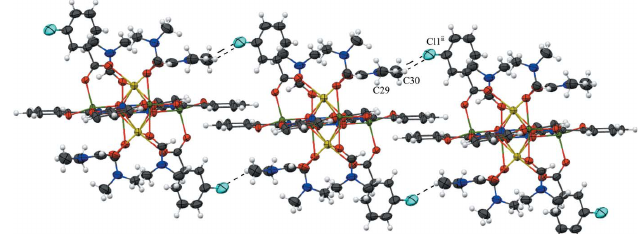
Figure 4 Intermolecular C—H (cid:2)(cid:2)(cid:2) Cl interactions in 1 between the hydrogen atoms (white) of the methyl groups of the DMF associated with O11 and the chlorine atom of the neighboring 3-chlorobenzoate anion [symmetry code: (ii) x + 1, y , z + 1]. The interactions result in a one-dimensional network. For clarity the disorder has been omitted and only the atoms involved in the interactions have been labeled.